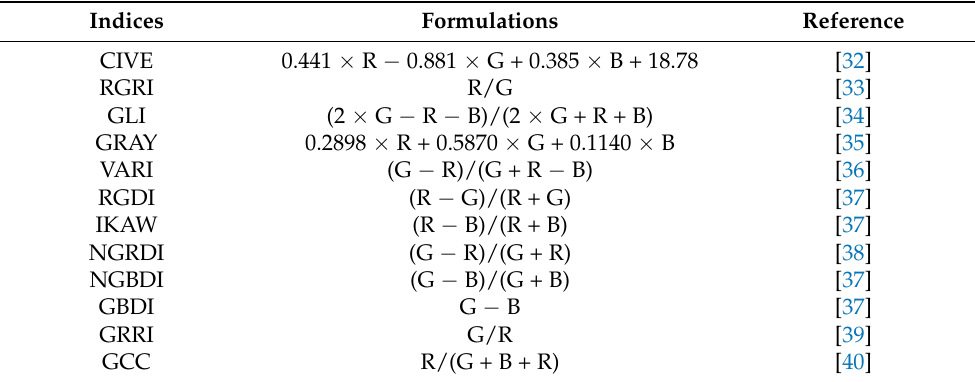
Table 1. The commonly applied RGB-based vegetation